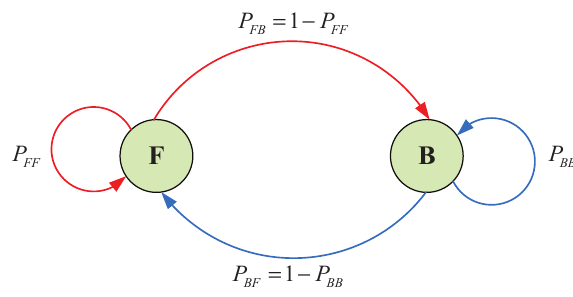
Figure 3. Markov chain model of the primary